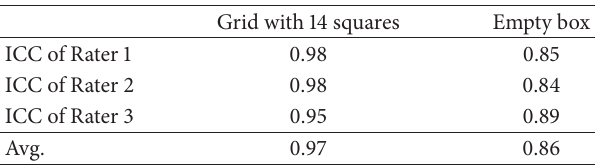
Table 2: Intrarater reliability for the area of retinal hemorrhage measured by using a grid with 14 squares and empty box. Grid with 14 squares Empty box ICC of Rater 1 0.98